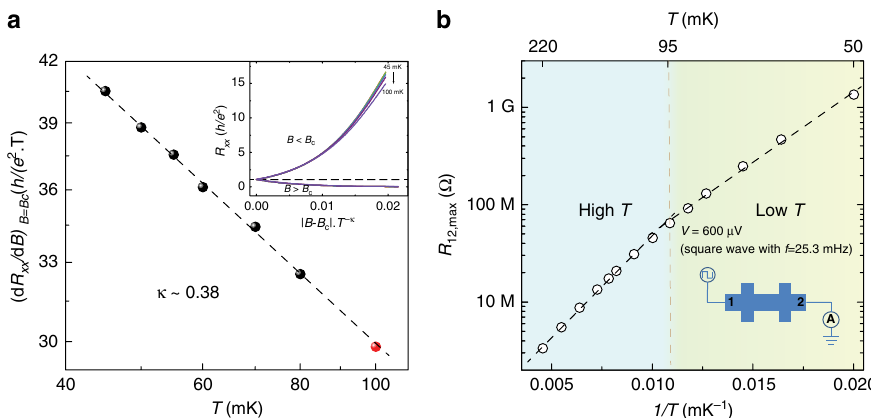
on log – log scale. The black dashed line c